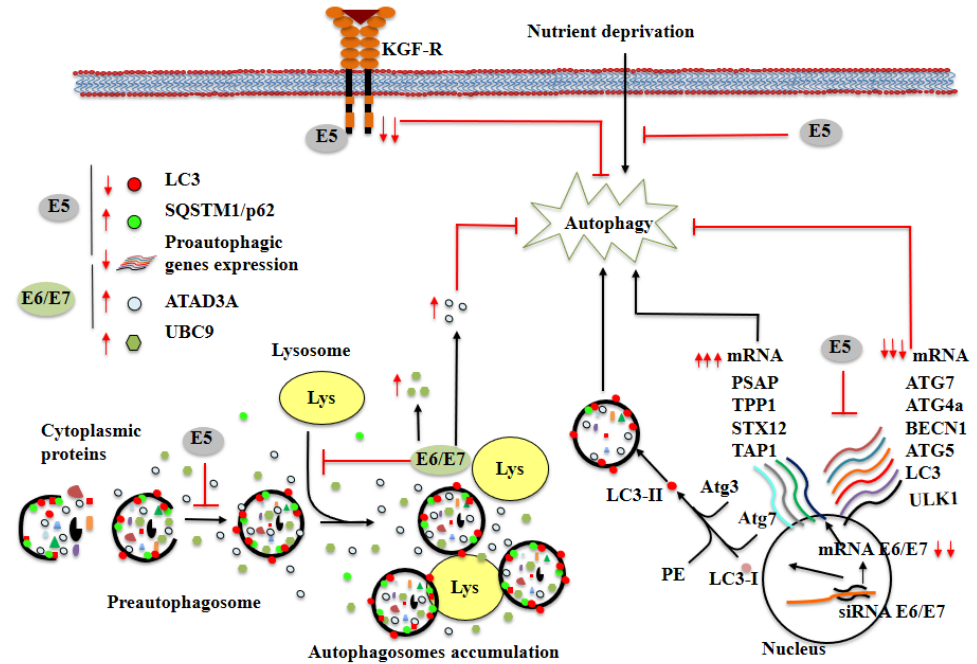
Figure 2. Modulation of autophagy by HPV16 E5, E6, and E7 oncoproteins. The image summarizes the effects of viral oncoproteins on both mRNA and cellular protein levels. HPV16 E5 oncoprotein inhibits autophagy activation by decreasing the levels of KGFR, downregulating the expression of autophagic genes, inhibiting the degradation of p62 and reducing the levels of LC3-II. E6/E7 expression increases the levels of UBC9 and ATAD3A proteins, protects cells from autophagy, and reduces fusion between the autophagosome and lysosomes. Silencing of E6 and E7 increases both the expression of autophagy-related genes and lipidation of LC3B, and reduces p62 protein levels. Red lines ( ) indicate inhibition black arrows ( ) indicate activation. Red arrows represent increase ( ) or decrease ( ) in mRNA or cellular proteins, respectively. See the text for more details. It appears that the inhibition of autophagy by E6 and E7 oncoproteins by HPV16 is not an exclusive feature of the alphapapillomavirus genus; other genera such as the betapapillomavirus genus can produce similar effects. Akgül et al. demonstrated that co-expression of E6 and E7 proteins from HPV8 (a papillomavirus associated with squamous cell carcinoma of the skin) downregulates checkpoint kinase-1 (CHK1) protein levels in keratinocytes. A decrease in CHK1 and LC3B protein levels was